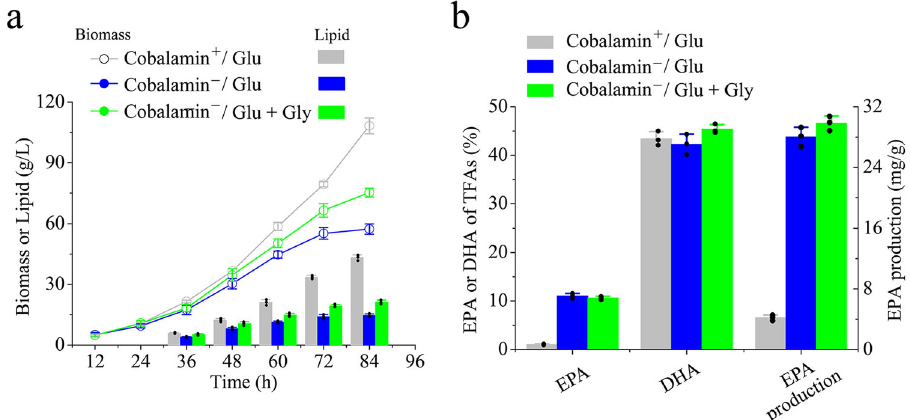
Fig. 6 Production of EPA using Schizochytrium sp. by fed-batch culture. a Time courses of Biomass (or dry cell weight) and Lipid in fed-batch culture. b EPA ratio, DHA ratio, and EPA production (mg/g dry cell weight) of Schizochytrium sp. (84 h) in fed-batch culture. The statistical signi fi cances of the fi nal results were analyzed by t-test, * p <